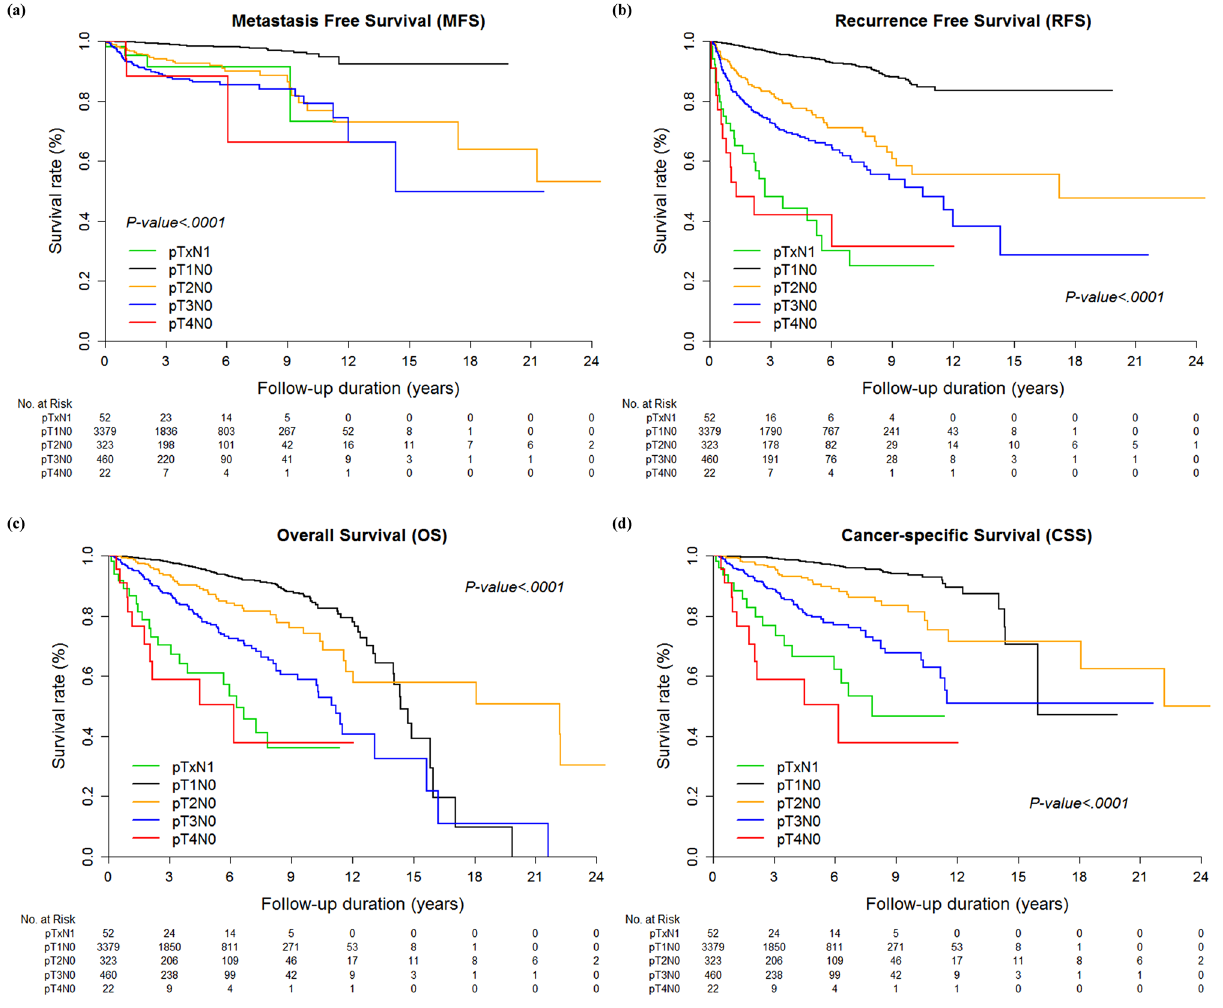
Figure 1. Kaplan–Meier curves for ( a ) MFS, ( b ) RFS, ( c ) OS, and ( d ) CSS in five pTN